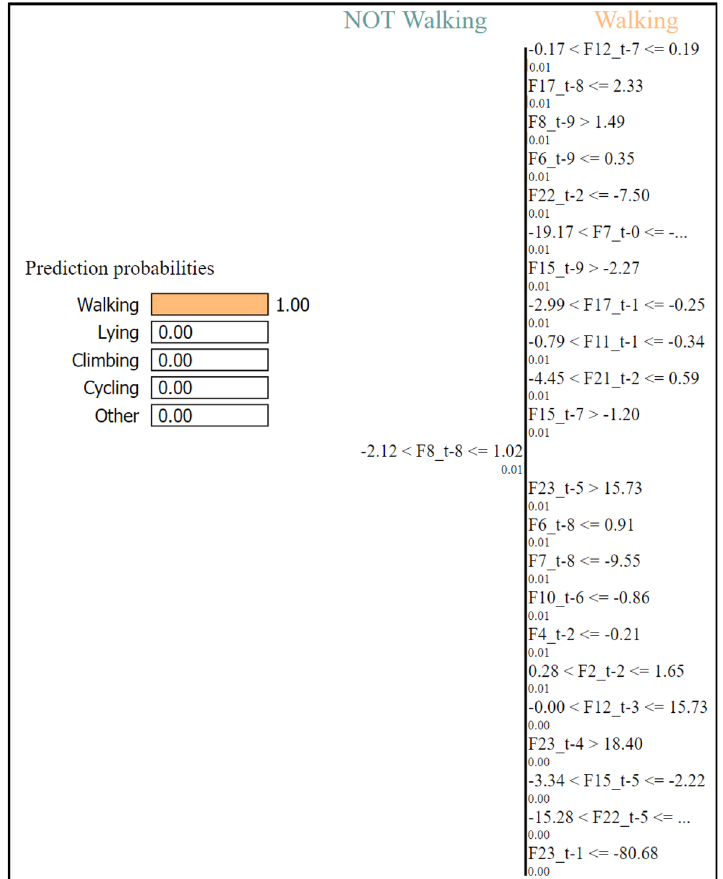
Figure 12. Prediction probabilities of the activities and feature range as well as probabilities of walking versus others, for a test sample of walking